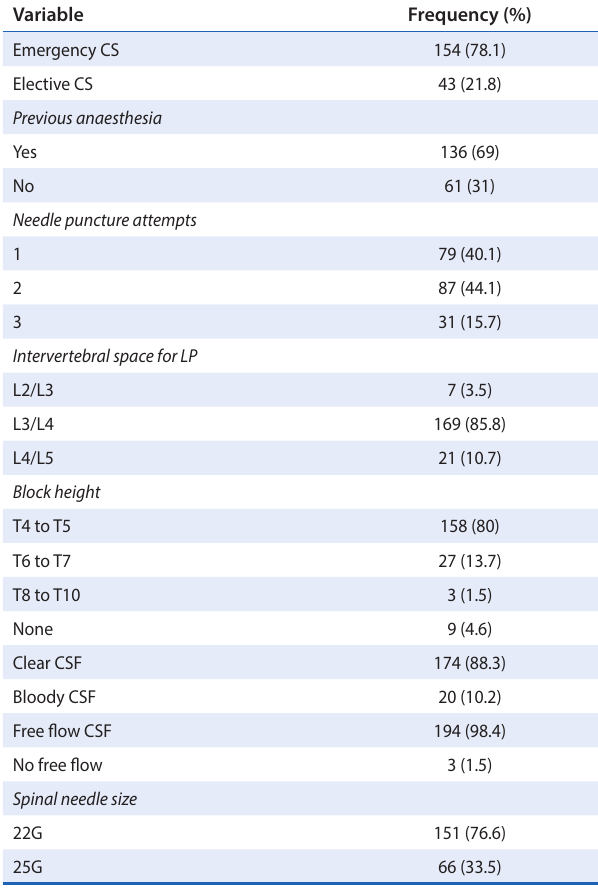
Table 2: Procedure-related